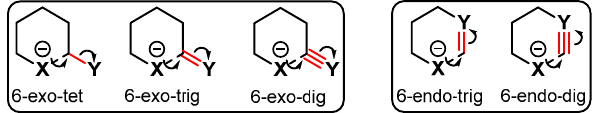
Figure 2. Main routes of intramolecular cyclization.